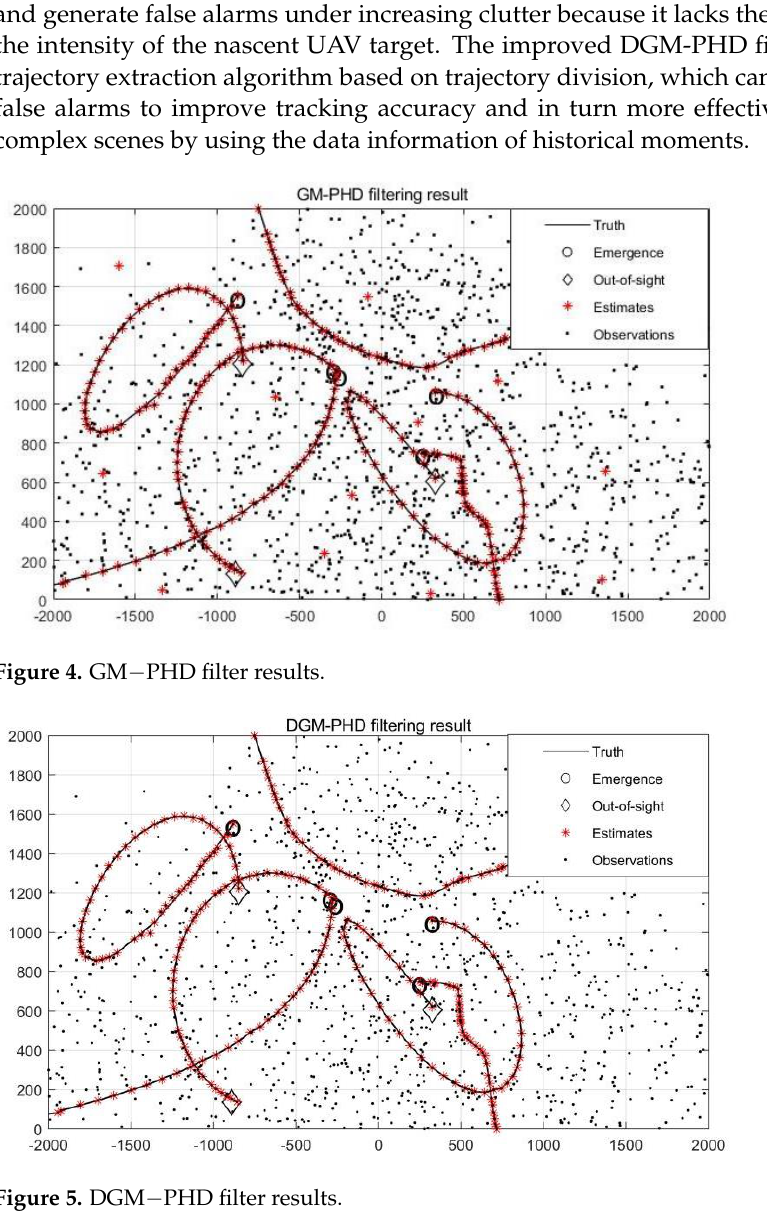
Figure 3. Real trajectories of UAVs.